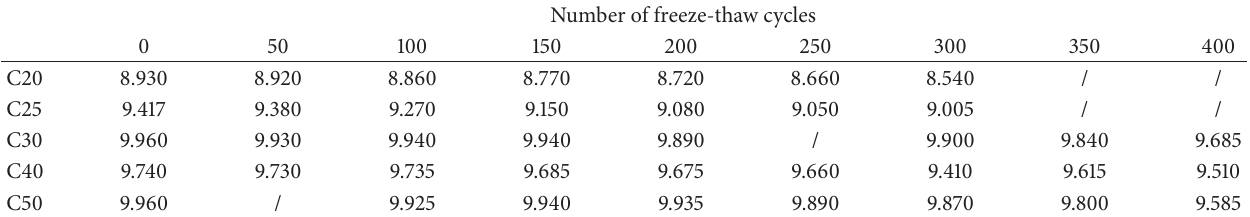
Table 3: Weight of air-entrained concrete after different cycles of freeze-thaw (Kg). Number of freeze-thaw cycles